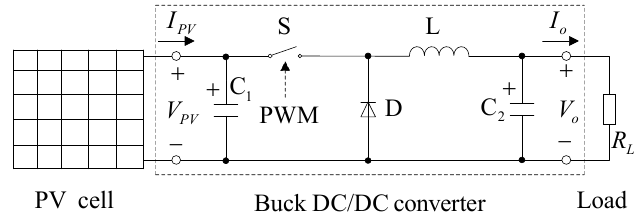
Figure 1. Configuration of the usual PV system.